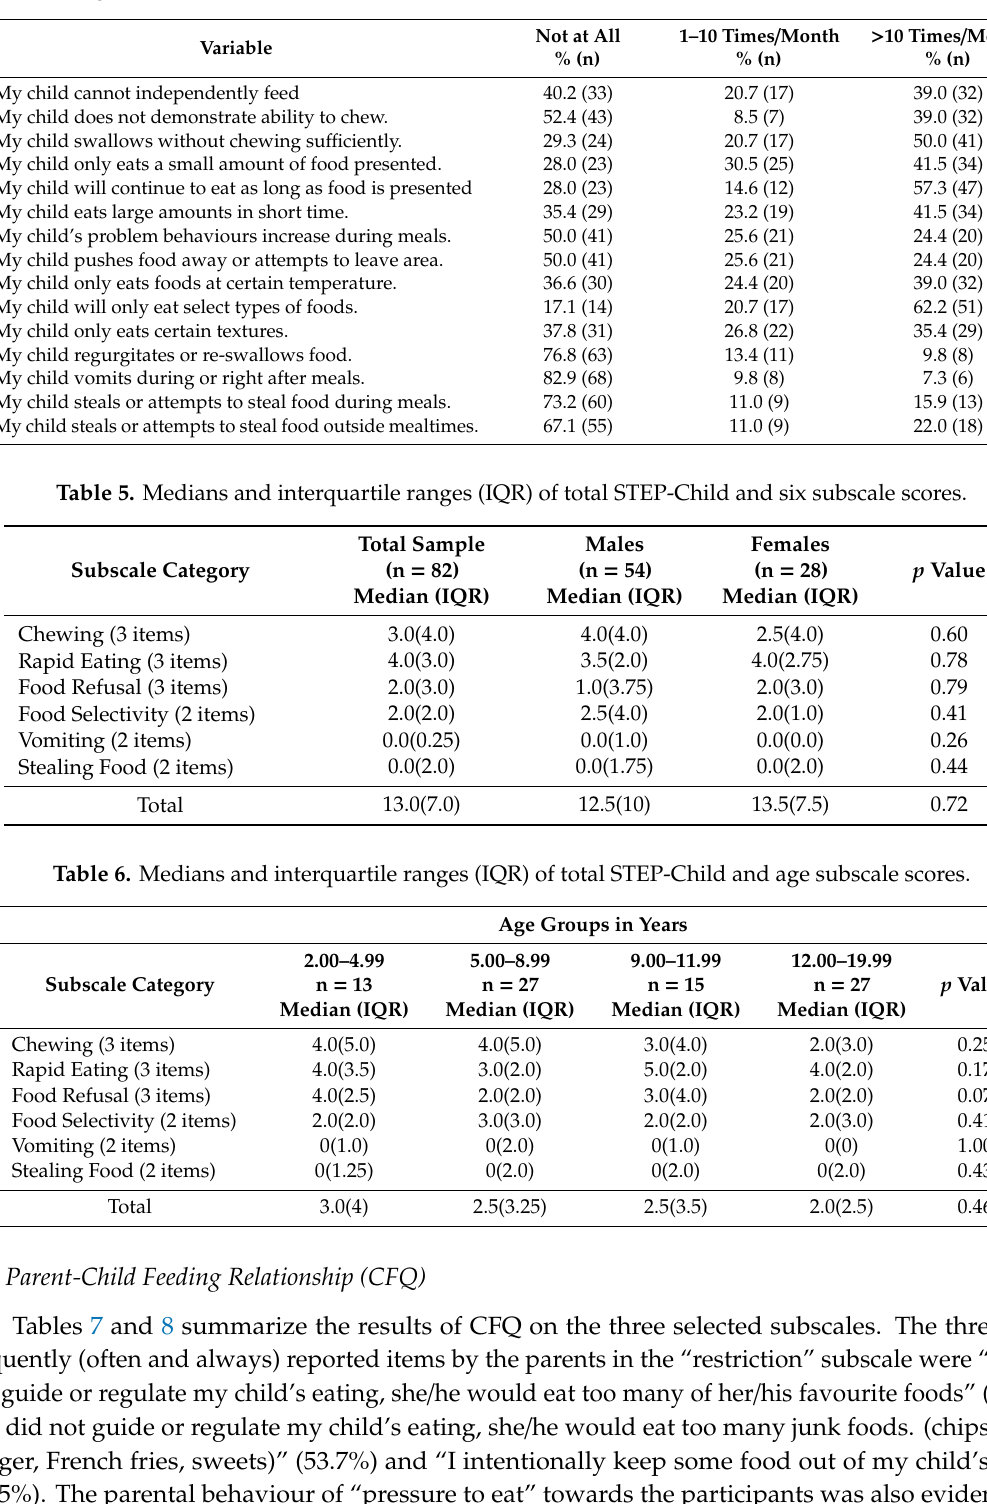
Table 4. Distribution of participants according to frequency of reported feeding problems on STEP-Child screening tool (n = 82).